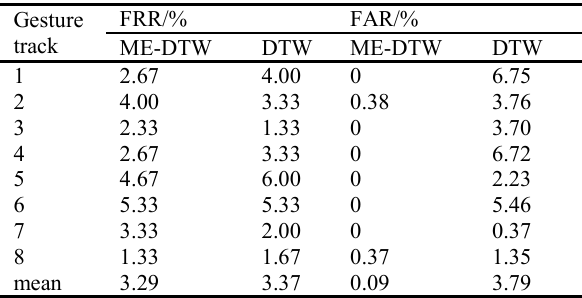
Table 1 .Compare with ME-DTW and